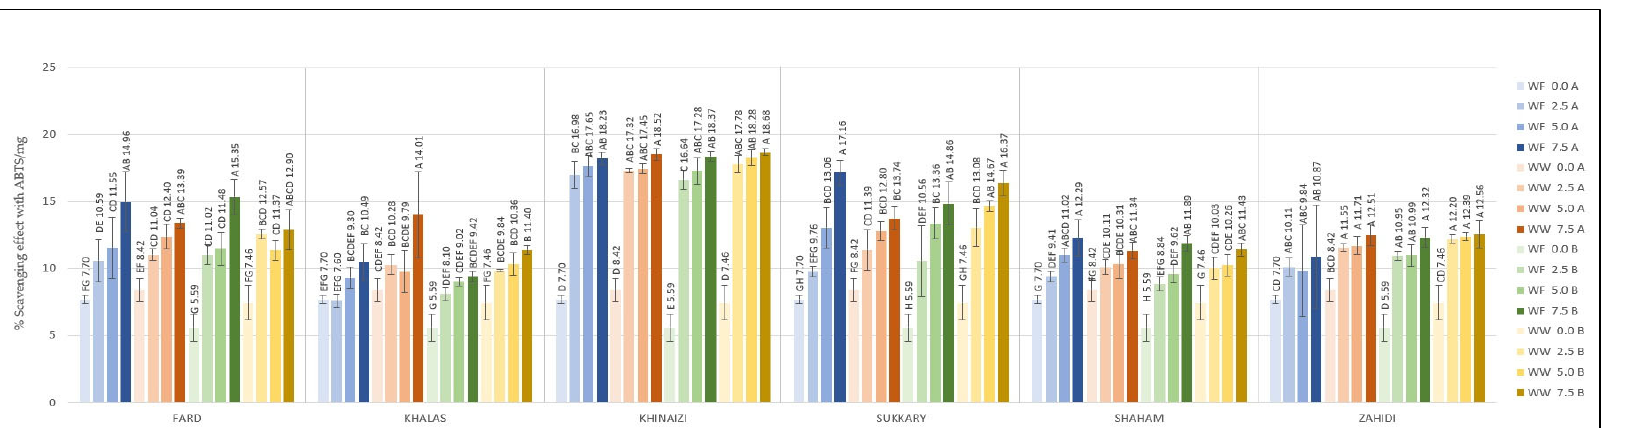
Figure 6. ABTS radical scavenging (% Scavenging effect with ABTS/mg) of composite cookies formulated with 2.5%, 5%, and 7.5 % substitution of flour by date seed powder. Different superscript letters in a variety denote significant differences, p < 0.05. (A—180 °C, B—200 °C).